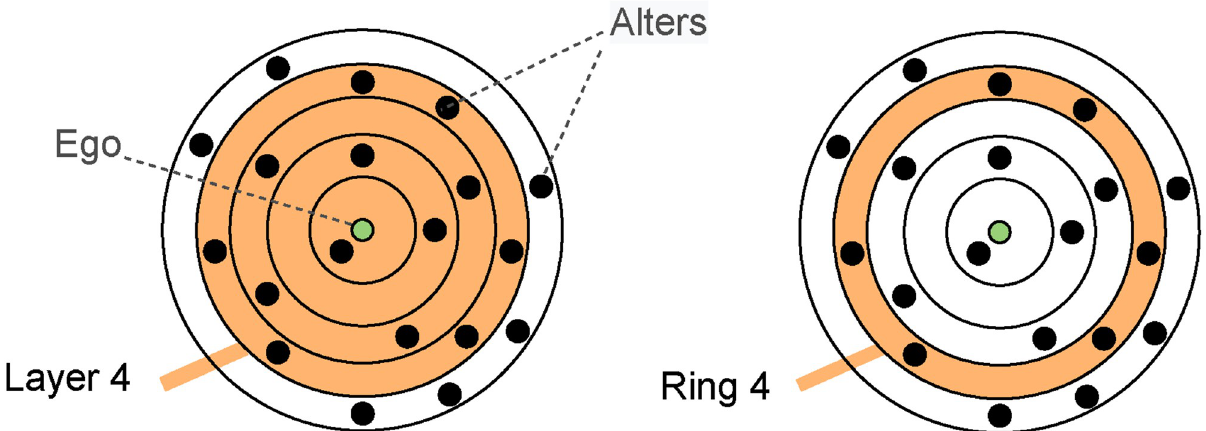
Fig 1. The ego network of social relationships. The green dot symbolizes the ego and the black dots the alters with whom the ego maintains an active social relationship. A layer also contains the alters of the inner layers, unlike the